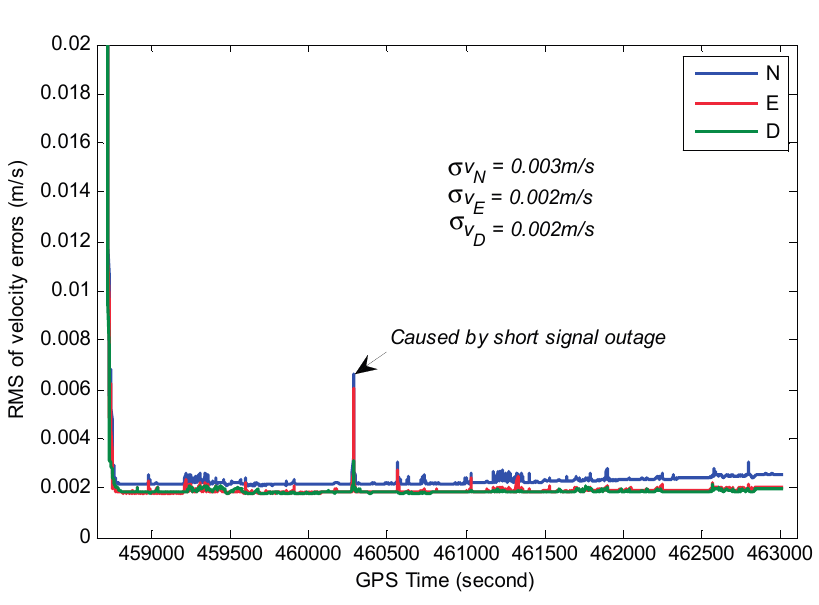
Figure 17. RMS of the estimated position errors.